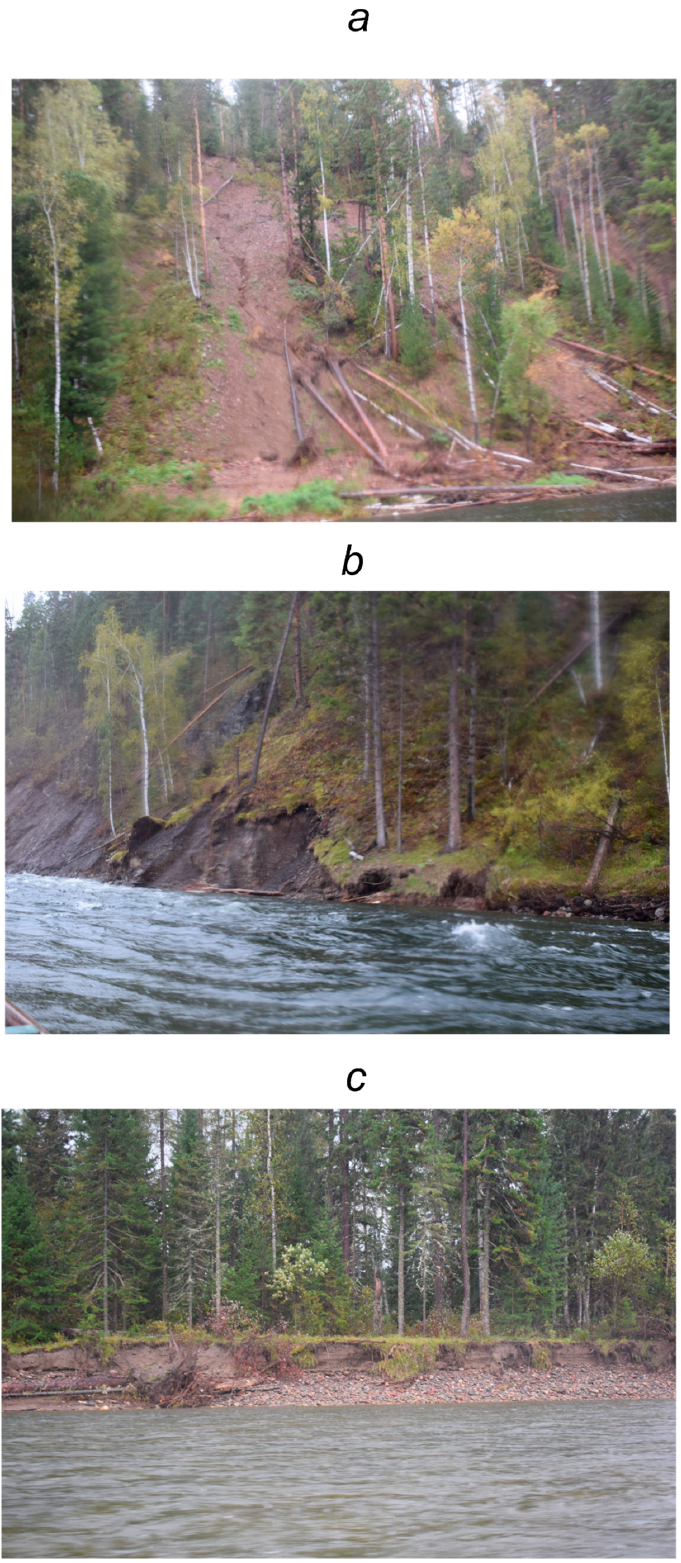
Figure 9. Slope processes of the IyaRiver valley in the piedmont of the Eastern Sayan: ( a )—debris flows; ( b )—debris slides in the lower part of the root slope; ( c )—sliding of the soil in the scarp of the